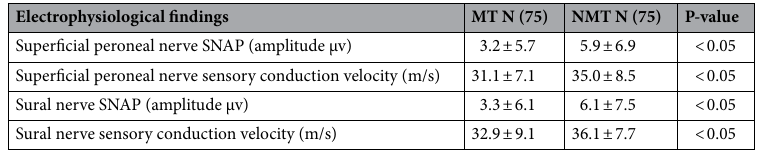
Table 3. Comparison of nerve conduction study features for metformin-treated and non-metformin-treated groups. SNAP: sensory nerve action potential, MT: metformin-treated, NMT: non-metformin-treated, N: number.